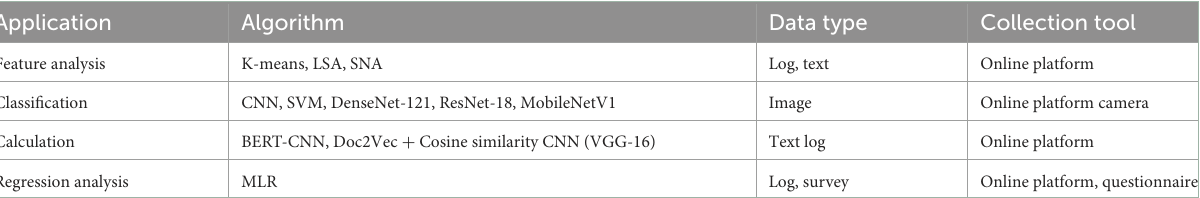
TABLE 8 Automatic analysis measures of learning engagement in massive open online courses.